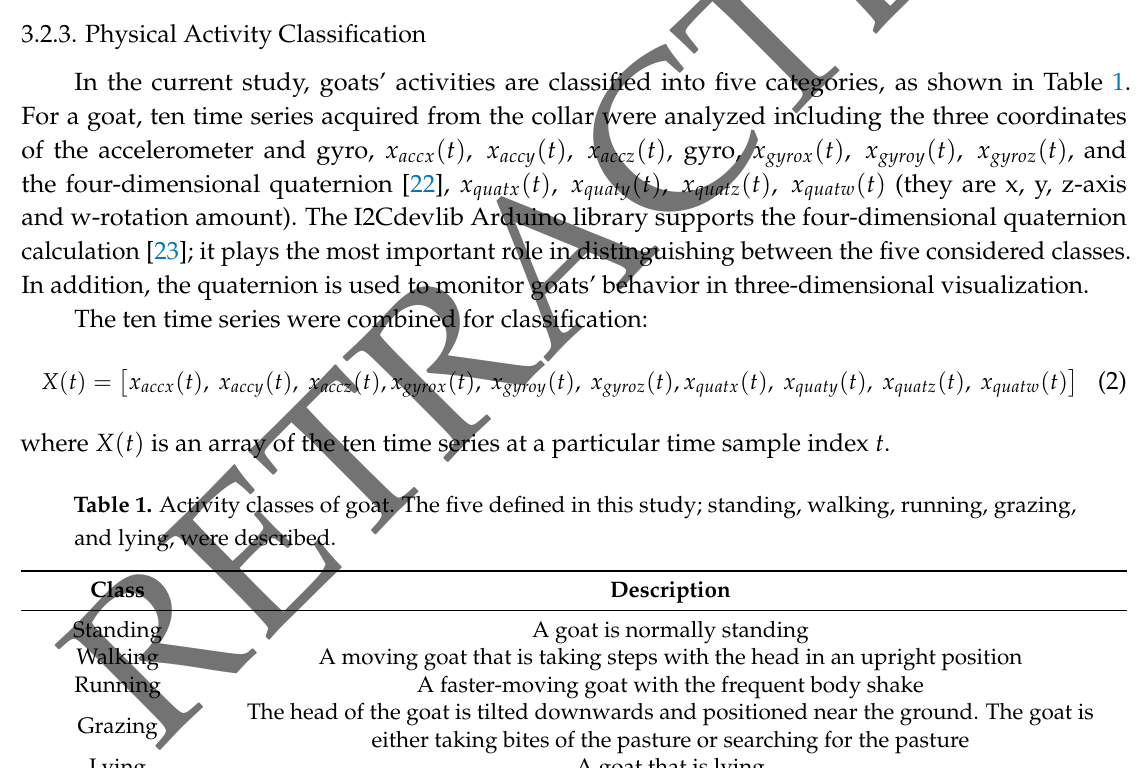
Table 1. Activity classes of goat. The five defined in this study; standing, walking, running, grazing, and lying, were